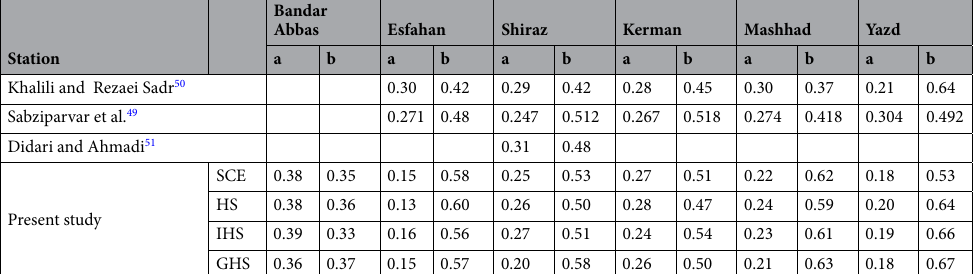
Table 6. Comparison of calibrated coefficients of the A–P model in the present study with the results of other researchers.